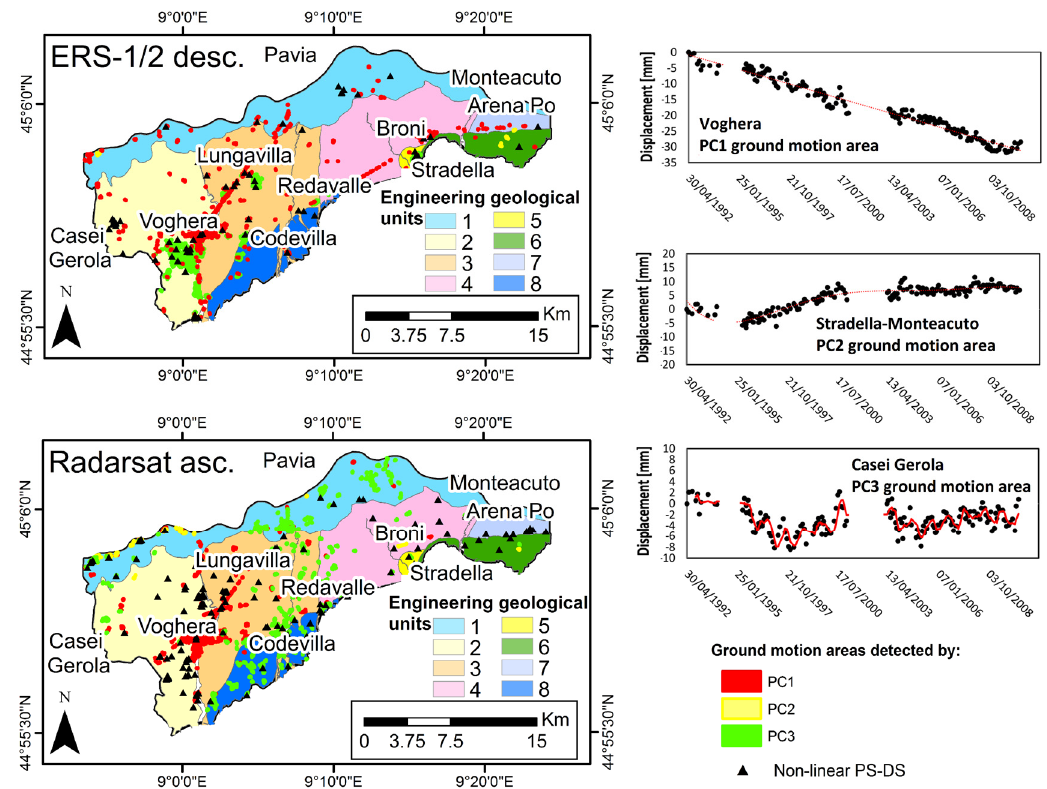
Figure 6. Ground motion areas detected using PC1, PC2, and PC3, and non-linear PS-DS of the ERS-1/2 desc. and Radarsat asc. data overlapped on the engineering geological units. TS of the deformational behavior detected at Voghera, Stradella–Monteacuto, and Casei Gerola are also reported. In the case of Voghera, it is represented by the TS linear regression line (dotted red line). Conversely, for Stradella–Monteacuto a 5° order polynomial regression line (dotted red line) is reported. For the TS detected at Casei Gerola, the red line is the moving average over a period of four months.